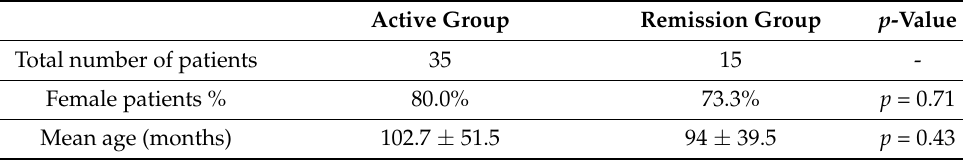
Table 1. Demographic, clinical, and laboratory features, and CE − /US+ in the active and remission groups. ESR, erythrocyte sedimentation rate; CRP, C reactive protein; ANA, anti-nuclear antibod- ies, CE, clinical examination; US, ultrasound. Of note, disease duration is significantly higher in the remission group while the number of CE − /US+ joints per patient is higher in patients with active